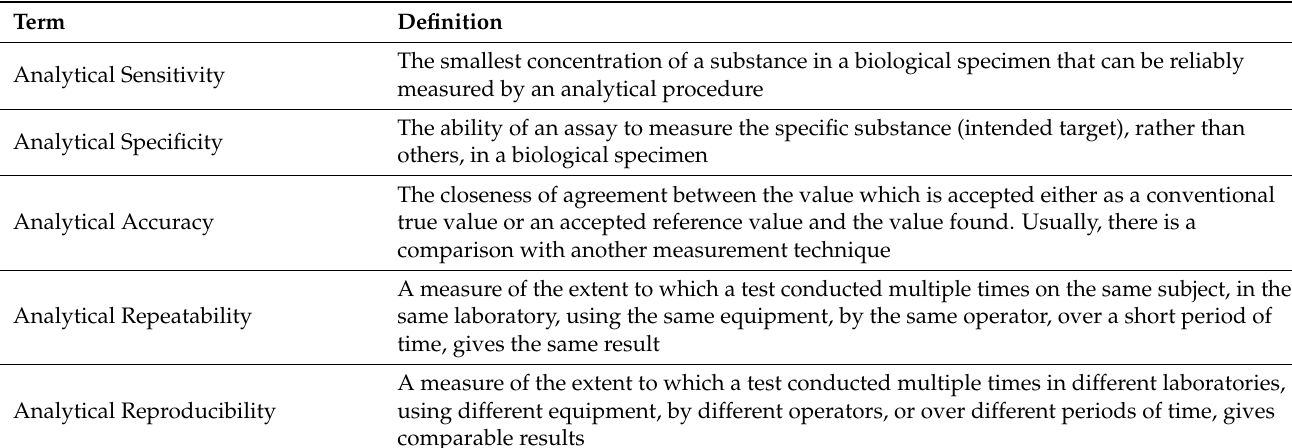
Table 4. Definitions of terms assessed in analytical validation, according to References